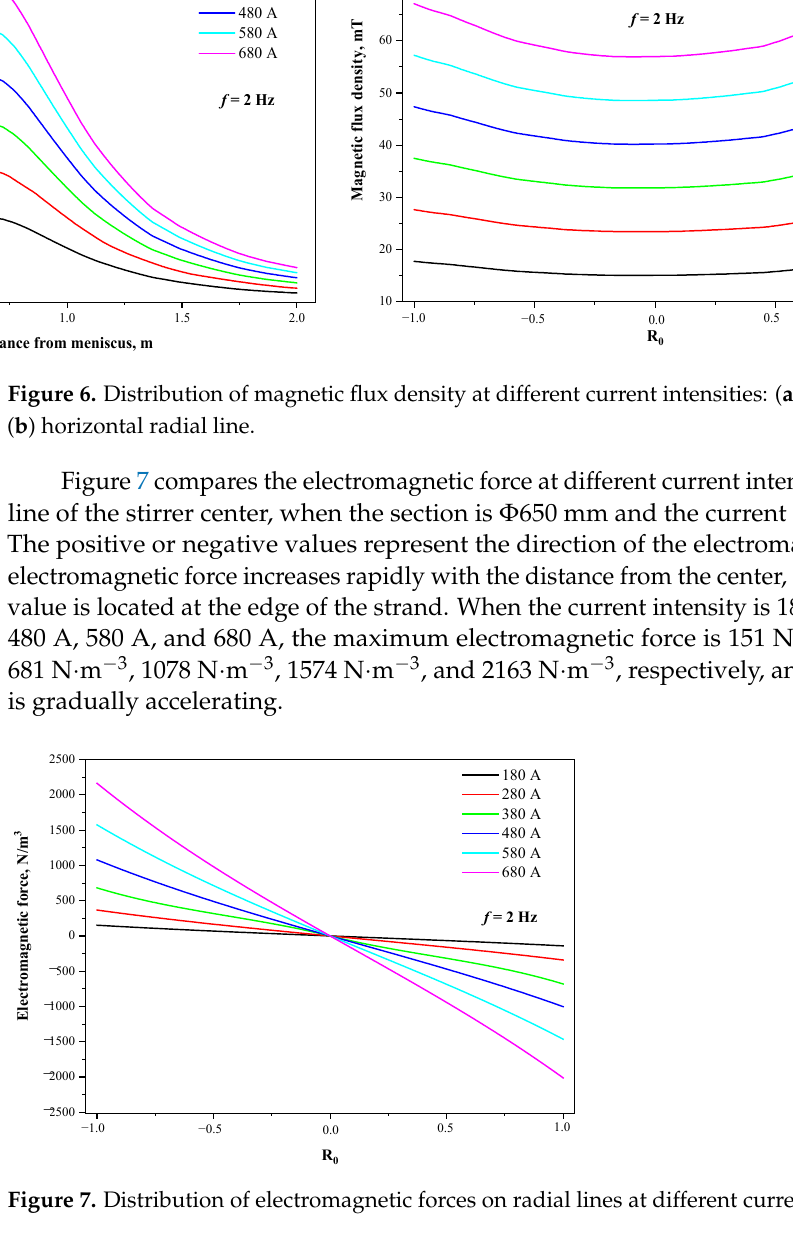
Figure 7. Distribution of electromagnetic forces on radial lines at different current intensities. Figure 8 indicates the distribution of magnetic flux density on the center axis and horizontal radial line of the stirrer at the different current frequencies when the section is Φ 650 mm and the current intensity is 280 A. In fact, according to Abe’s law, the current frequency does not affect the magnetic flux density, and the magnetic shielding effect is quite obvious at the copper tube thickness of 31 mm, so the magnetic flux density at the same location decreases with the increase in current frequency. The position of the maximum magnetic flux density on the central axis also gradually shifts downward with increasing frequency until it stabilizes at the mold exit. The magnetic field at the frequency of 8 Hz can only effectively penetrate a copper tube with a thickness of 31.5 mm under the skin effect of the electromagnetic field, and the magnetic flux density near the meniscus decreases with increasing distance from the meniscus at a higher frequency, which is related to the equivalent penetration thickness of the magnetic field reaching this location. The magnetic shielding effect after exiting the mold copper tube is substantially weak- ened, and finally the magnetic flux density curves at each frequency basically overlap.